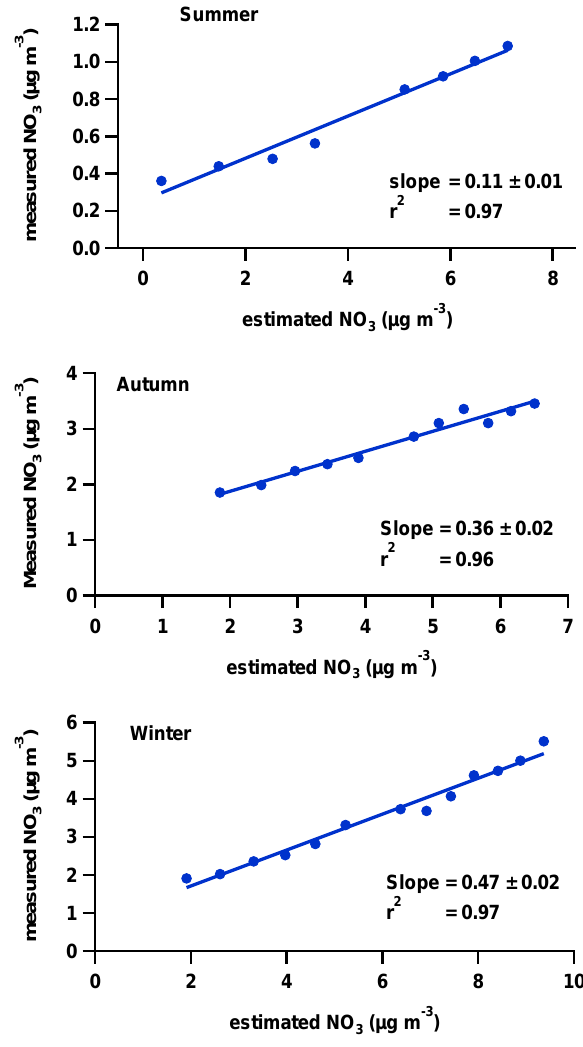
Figure 10. The comparison of measured and simulated nitrate concentrations for each season. 2 Fig. 10. The comparison of measured and simulated nitrate concen- trations for each